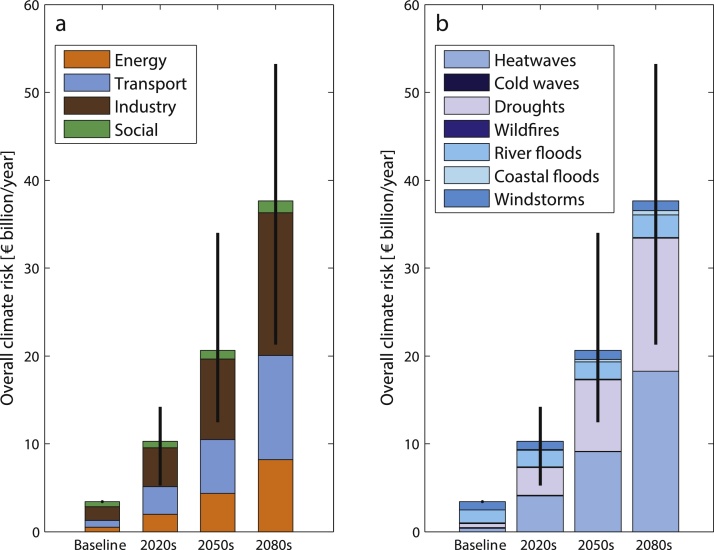
Overall climate hazard risk to critical infrastructures aggregated at European level (EU+) for each time period: a) distribution of damage by sector; b) distribution of damage over the seven hazards. For wind, projections of hazard are not available for 2020 s and 2050s; damage for these periods was obtained by linearly interpolating between the baseline and the 2080s. Whiskers reflect the inter-model climate variability.